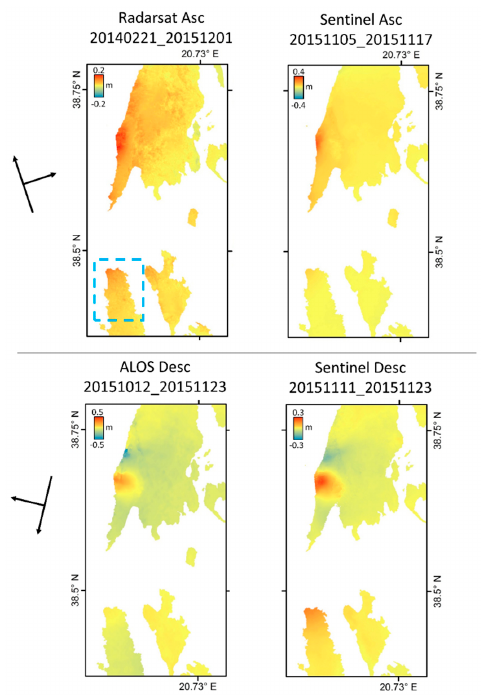
Figure 2. Displacement pattern from the different SAR sensors. The blue dashed rectangle is the area shown in Figure